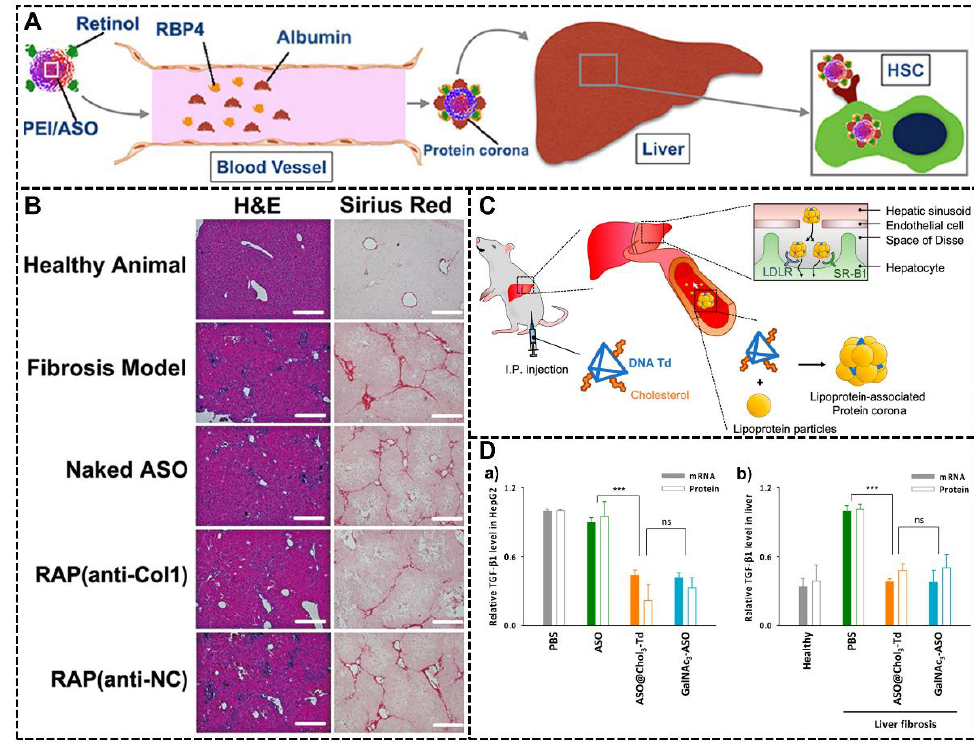
Figure 10. Other biomolecules modification to harness protein corona. ( A ) The schematic diagram of the NP system with retinol molecule modification. The retinol can selectively recruit the RBP4 and form a functional protein corona with numerous RBP4, directing the NPs-PC complex to the HSC in the liver and endowing this NP system with excellent drug delivery efficiency and therapeutic effects [91]. Copyright 2015, American Chemical Society. ( B ) The representative of H&E and Sirius red staining of liver tissue sections. The blue areas indicate the proliferating HSCs, and the red areas indicate the collagen deposition in the fibrotic liver tissues [91]. Copyright 2015, American Chemical Society. ( C ) The NP system with trivalent cholesterol conjugation (Chol3-Td) for ASO in vivo hepatocyte delivery. The cholesterol modification will enhance interaction with lipoproteins in serum and promote the formation of the lipoprotein-associated protein corona. This functional protein corona will facilitate the targeting of ASO delivery to the liver through the interaction with lipoprotein and related receptors like SR-B1 and LDLRs [95]. Copyright 2022, American Chemical Society. ( D ) Comparison of ASO@Chol3-Td with GalNAc3-ASO through estimating the potency of ASO (a) in HepG2 cells in vitro and (b) in liver fibrosis mice in vivo. ***, P < 0.001; ns, nonsignificant[95]. Copyright 2022, American Chemical Society.